Question: Summarize what this figure shows in one sentence.
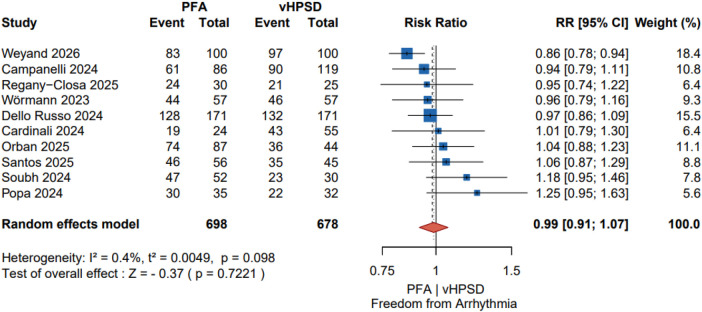
Answer: Forest plot of the main analysis results.